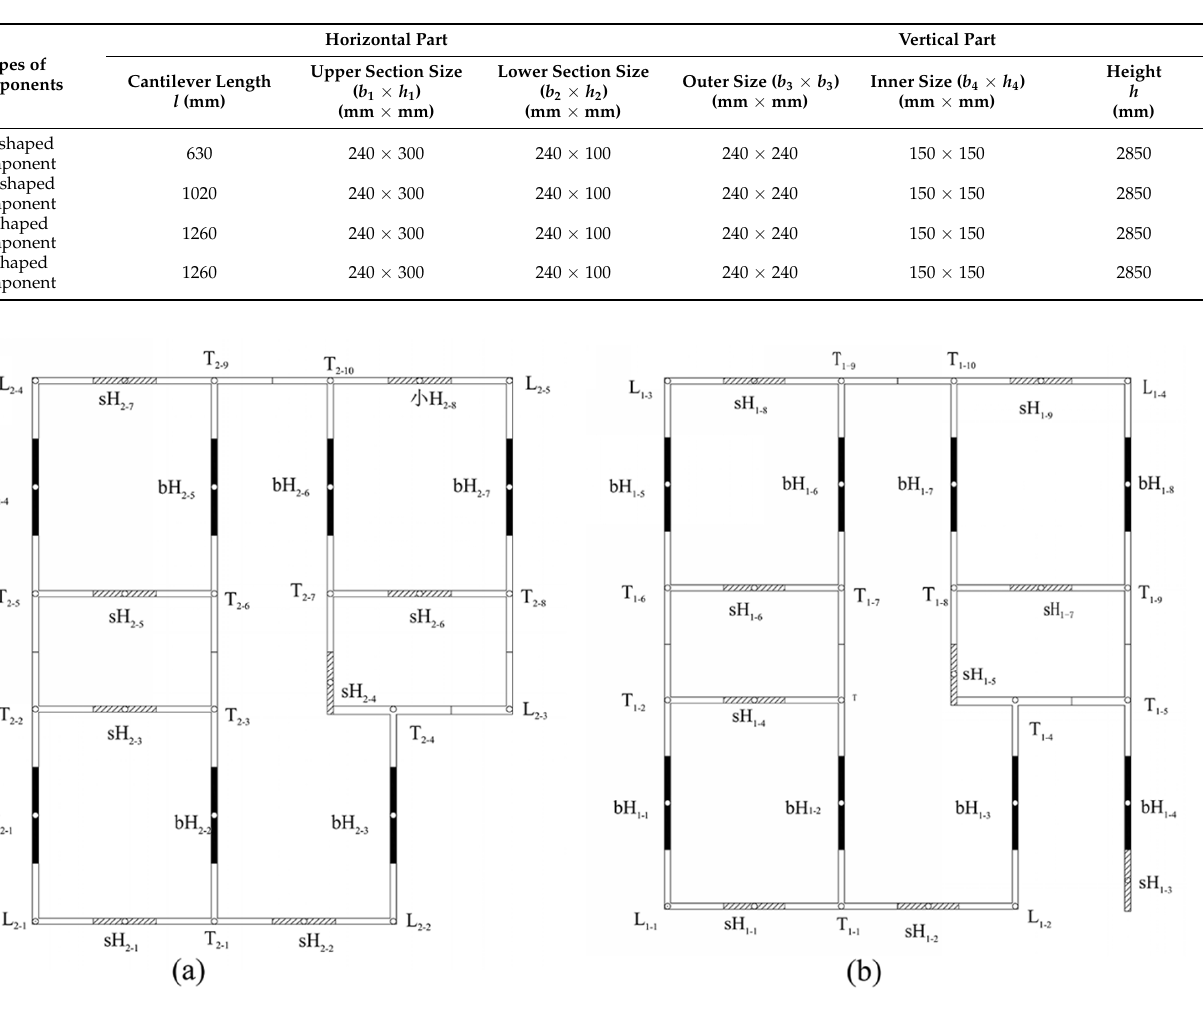
Figure 11. A 3D diagram of the prefabricated cantilever components arrangement: ( a ) First floor, ( b ) Second floor. C30 concrete and HRB400 rebar was chosen for all types of prefabricated cantilever components, while C40 expansive concrete was used as the post-cast concrete in the ver- tical part. Internal rebar in the vertical part of the prefabricated cantilever components were selected preliminarily as 12C12 (longitudinal rebar), C10@200 mm (stirrup). Thickness of protection cover is 20 mm. Square steel tubes with a thickness of 20 mm and external size